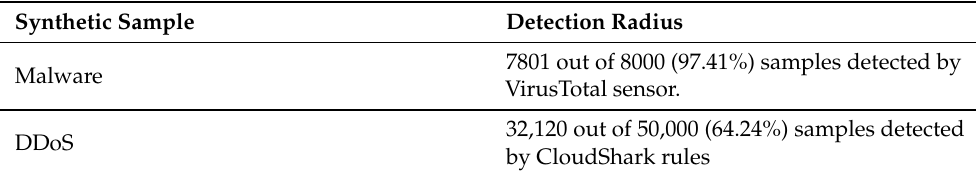
Table 6. Radius of detection of synthetic samples before